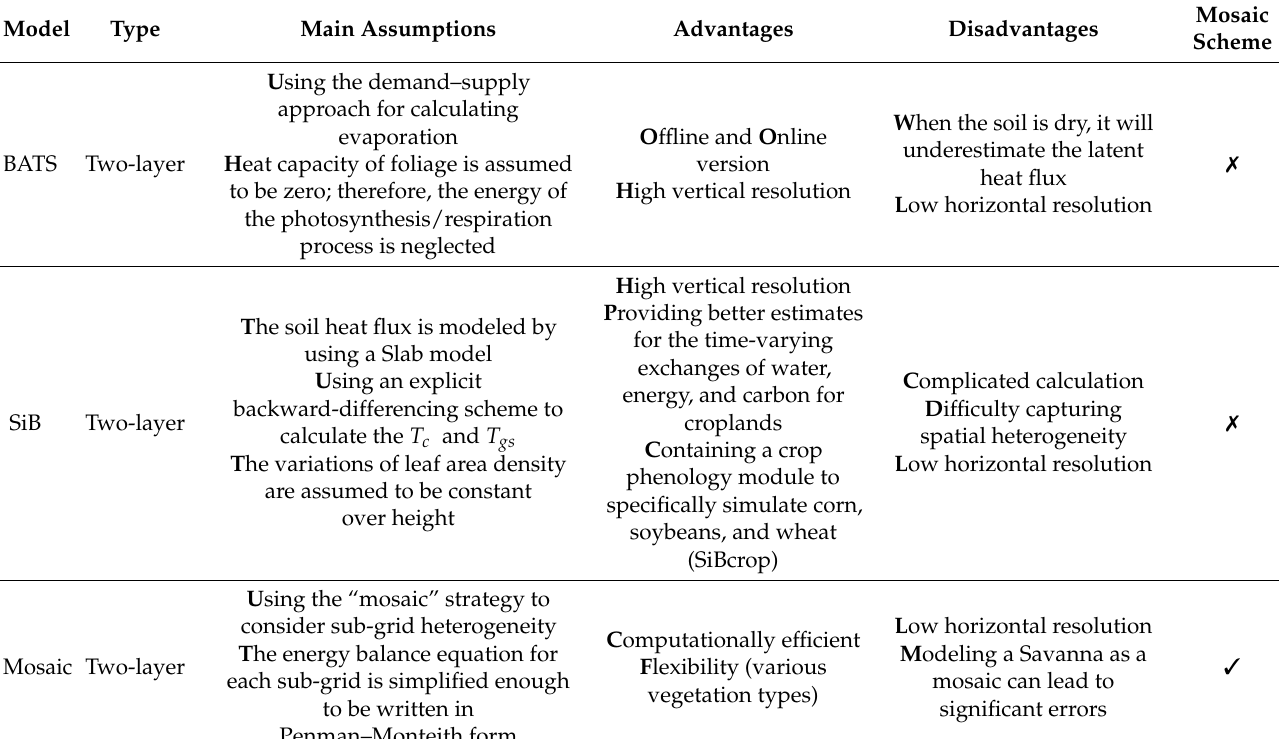
Table 1. A summary of the MT-based LSMs that follow approach